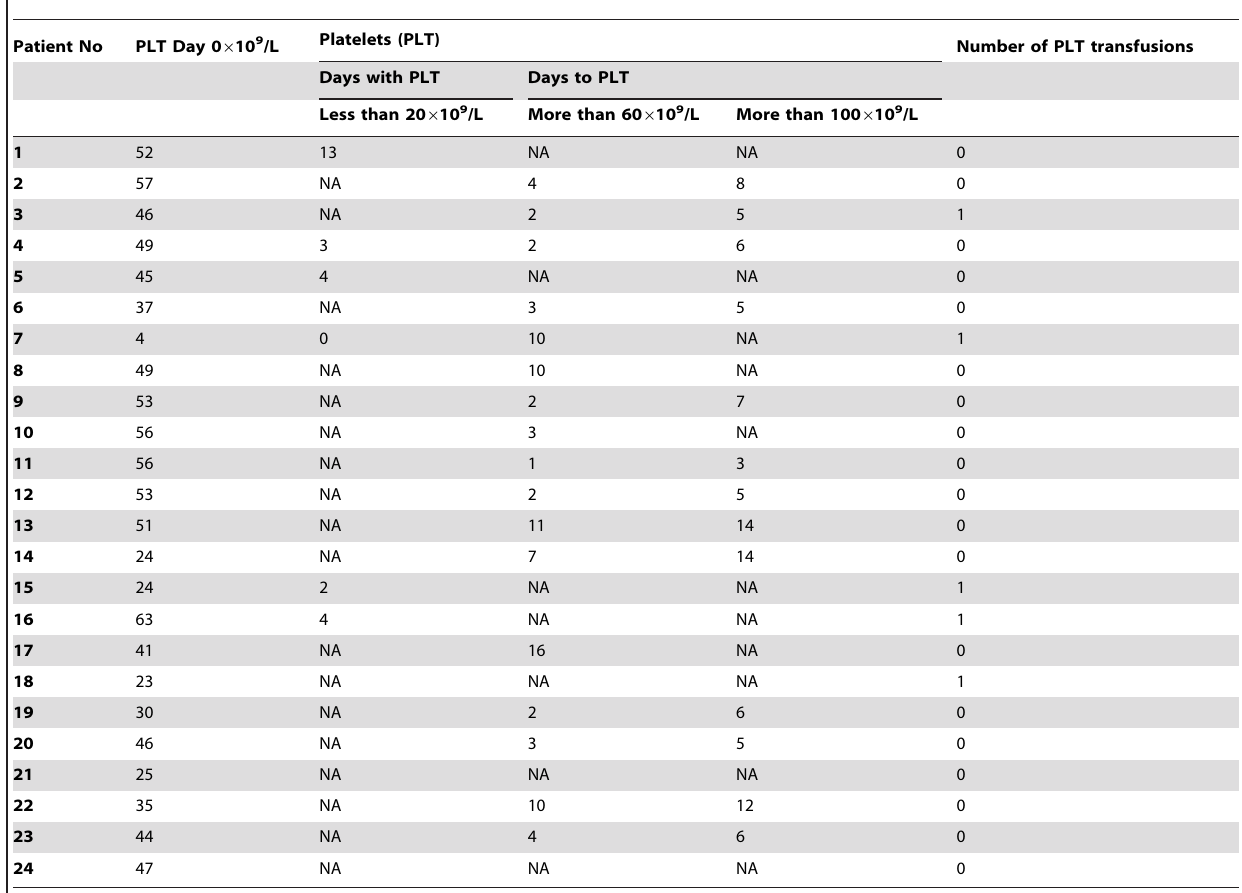
Table 4. Platelet recovery parameters after infusion of ex vivo -generated